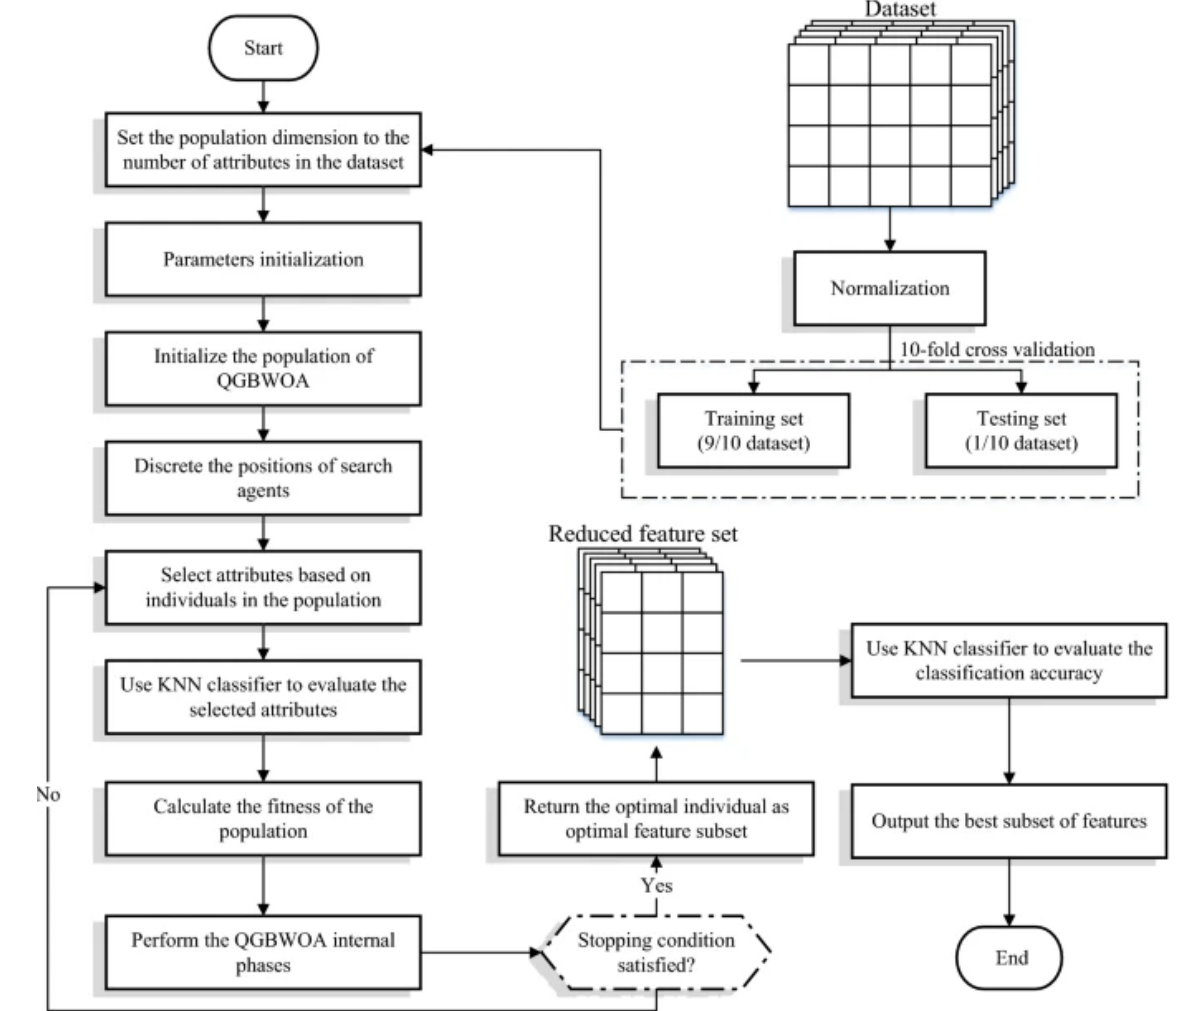
Figure 2. Proposed model framework. Electronics 2023 , 12 , x FOR PEER REVIEW